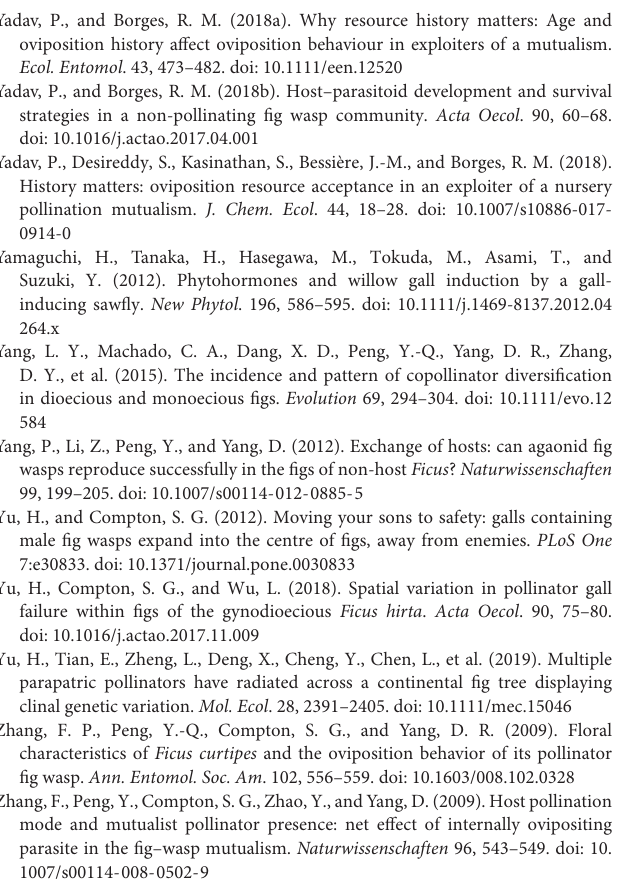
fig wasp. Ann. Entomol. Soc. Am . 102, 556–559. doi: 10.1603/008.102.0328